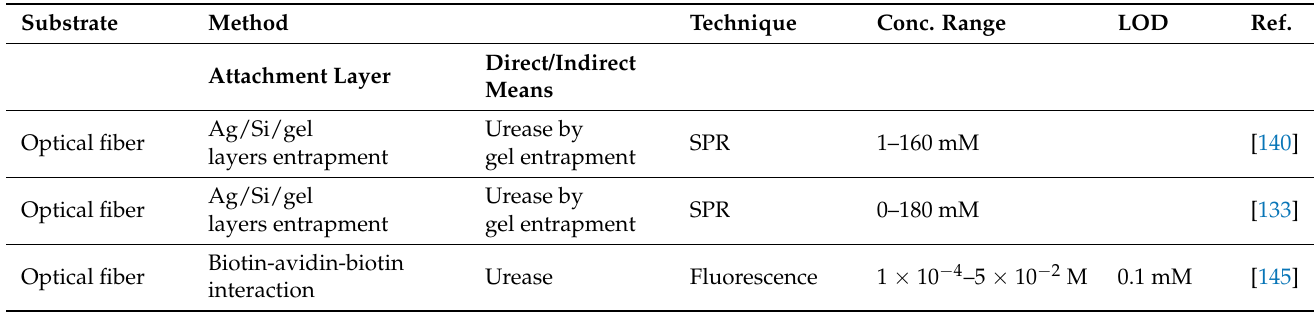
Table 2. Comparison of fiber optic urea sensors reported in the literature. Technique Conc. Range LOD